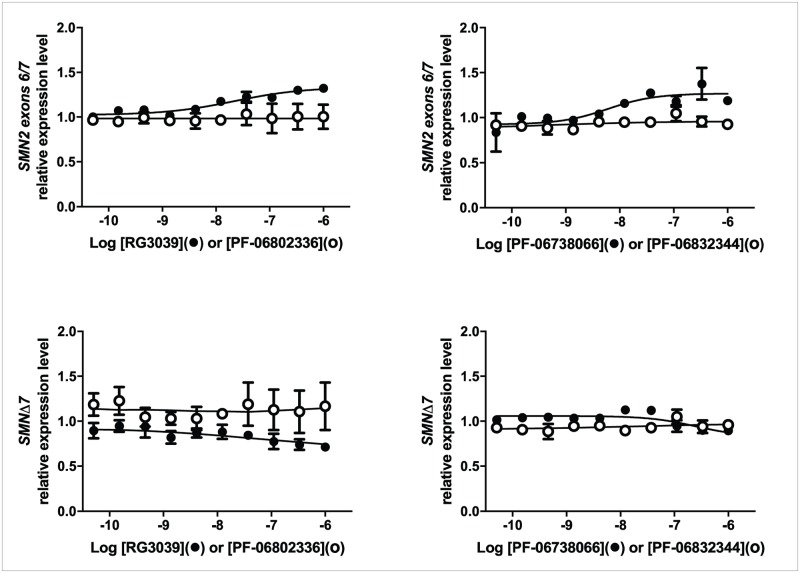
Effect of active DAQ-DcpSi and their 7-methyl analogues on SMN transcripts over time.SMA-derived lymphoblasts were treated with active DAQ-DcpSi (RG3039, PF-06738066) or their 7-methyl analogues (PF-06802336 and PF-06832344 respectively) and the levels of SMN transcripts measured using ddPCR. All data shown as mean ± s.e.m. and where not shown error bars are within the size of the symbols.